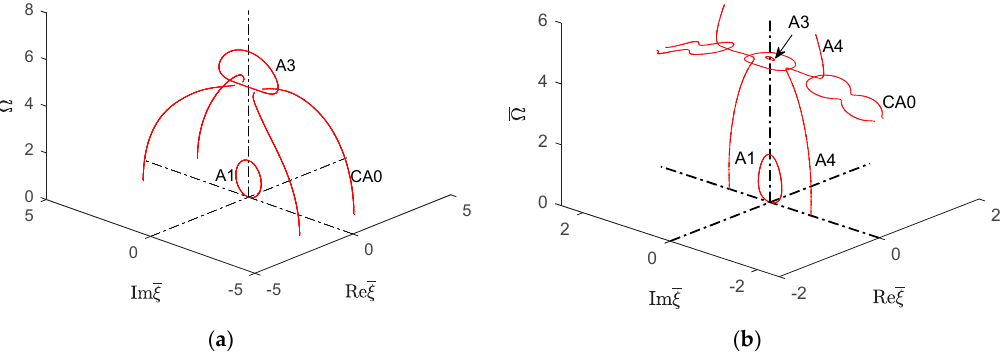
Figure 19. Imaginary (evanescent) and complex wavenumber solution for the first few antisymmetric modes of Lamb wave type GWs for ( a ) isotropic material and ( b ) unidirectional CFRP composite